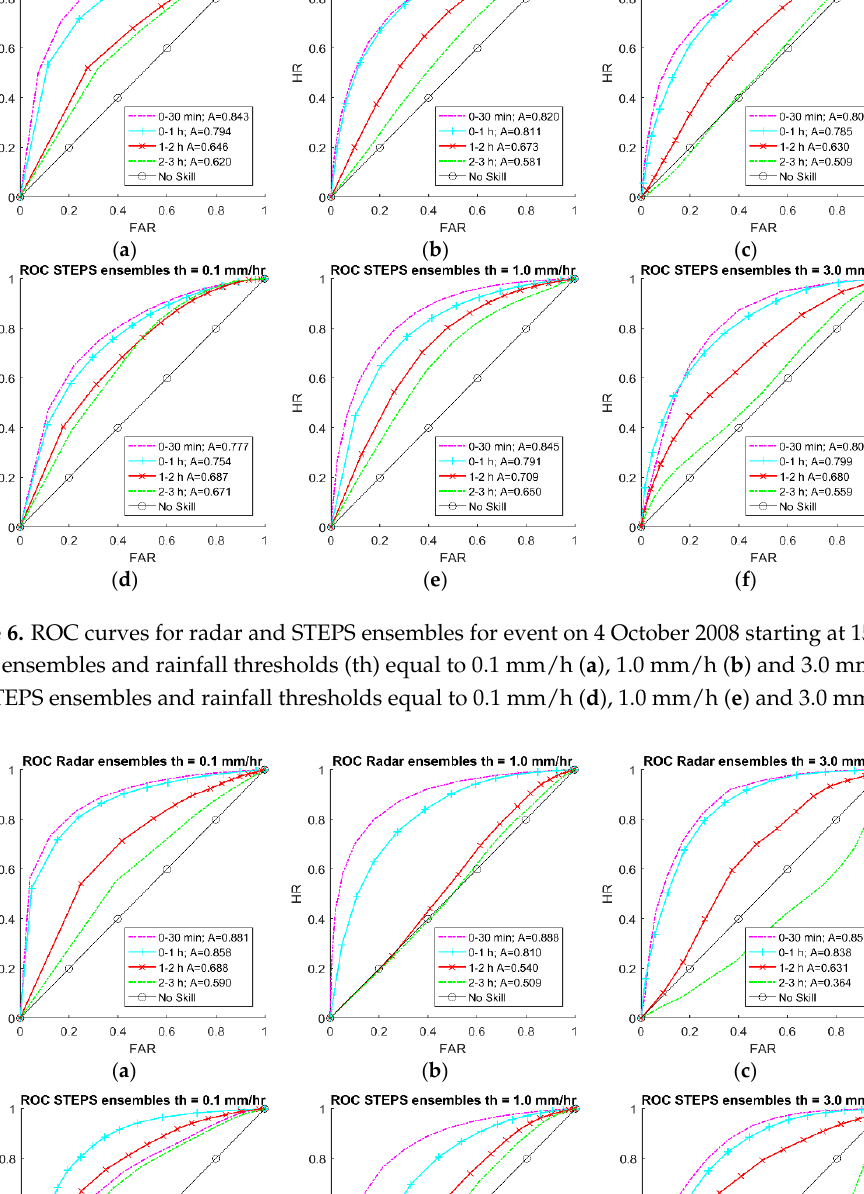
Figure 5. ROC curves for radar and STEPS ensembles for event on 1 August 2008 starting at 01:30 for Radar ensembles and rainfall thresholds (th) equal to 0.1 mm/h ( a ), 1.0 mm/h ( b ) and 3.0 mm/h ( c ). and STEPS ensembles and rainfall thresholds equal to 0.1 mm/h ( d ), 1.0 mm/h ( e ) and 3.0 mm/h ( f ).